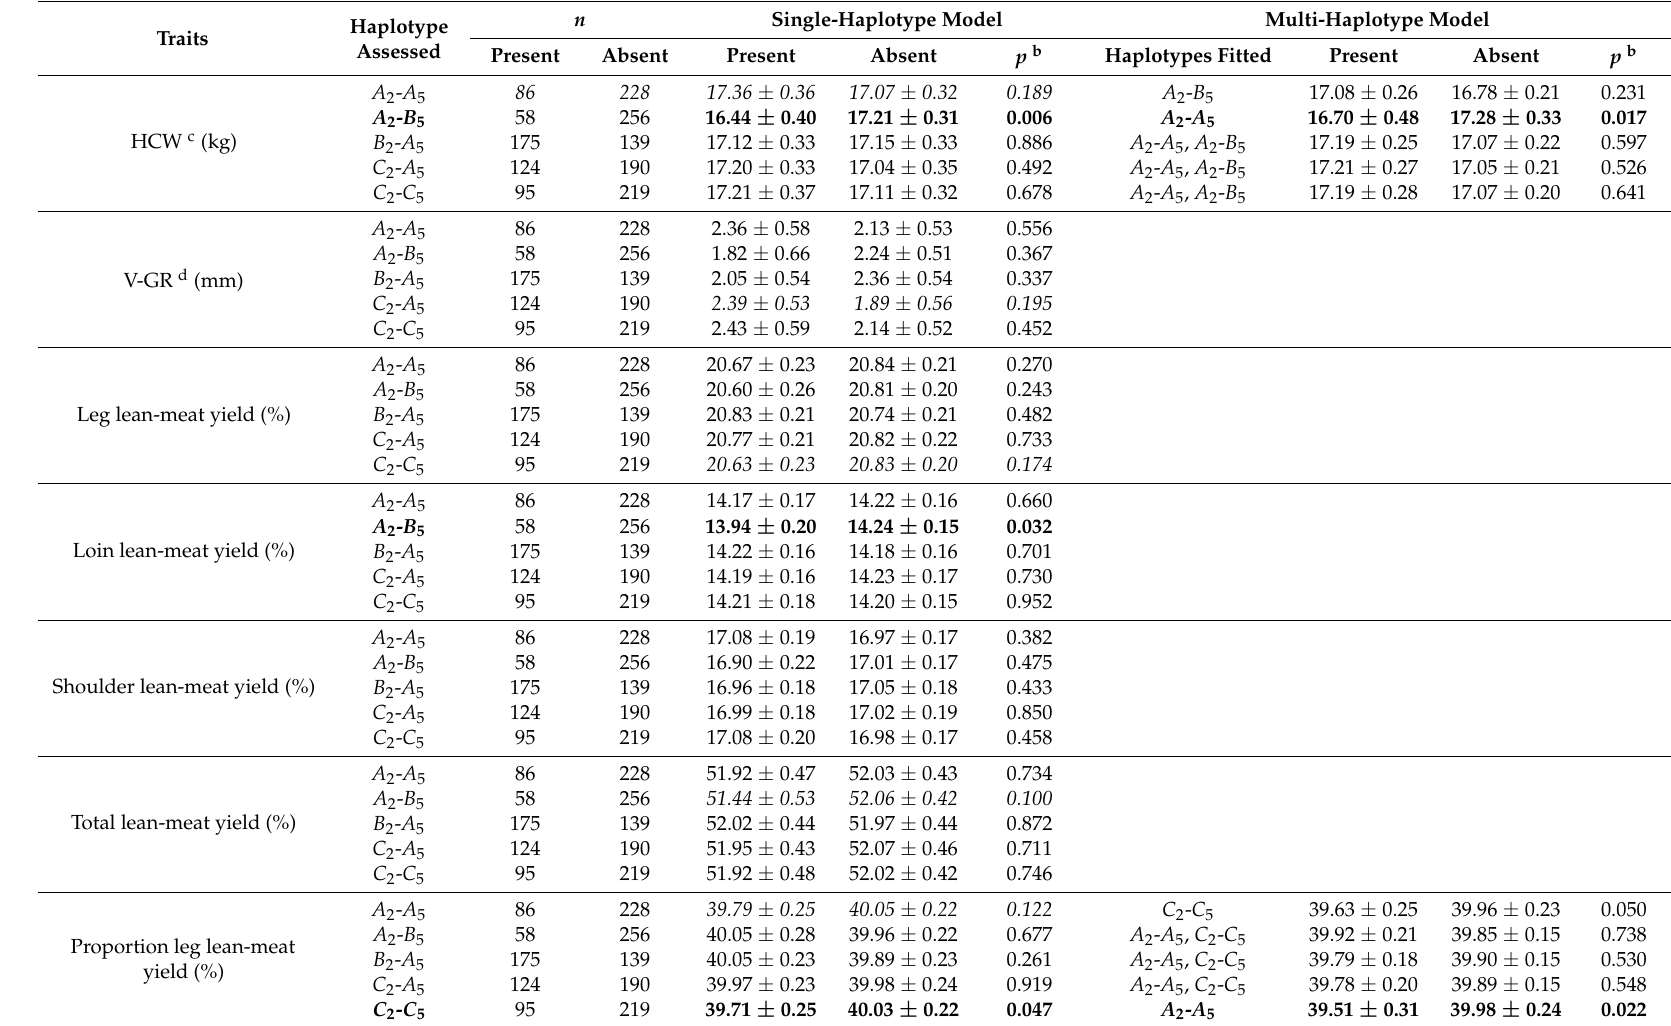
Table 3. Association of ovine UCP1 haplotypes with carcass muscles trait (Mean ± standard error (SE)) a in New Zealand (NZ) Romney sheep.